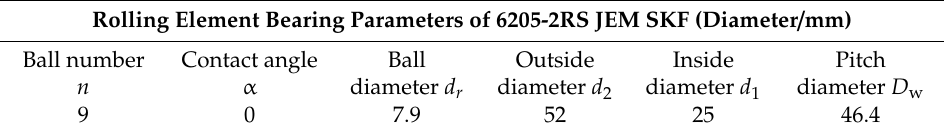
Table 3. Rolling element bearing parameters.